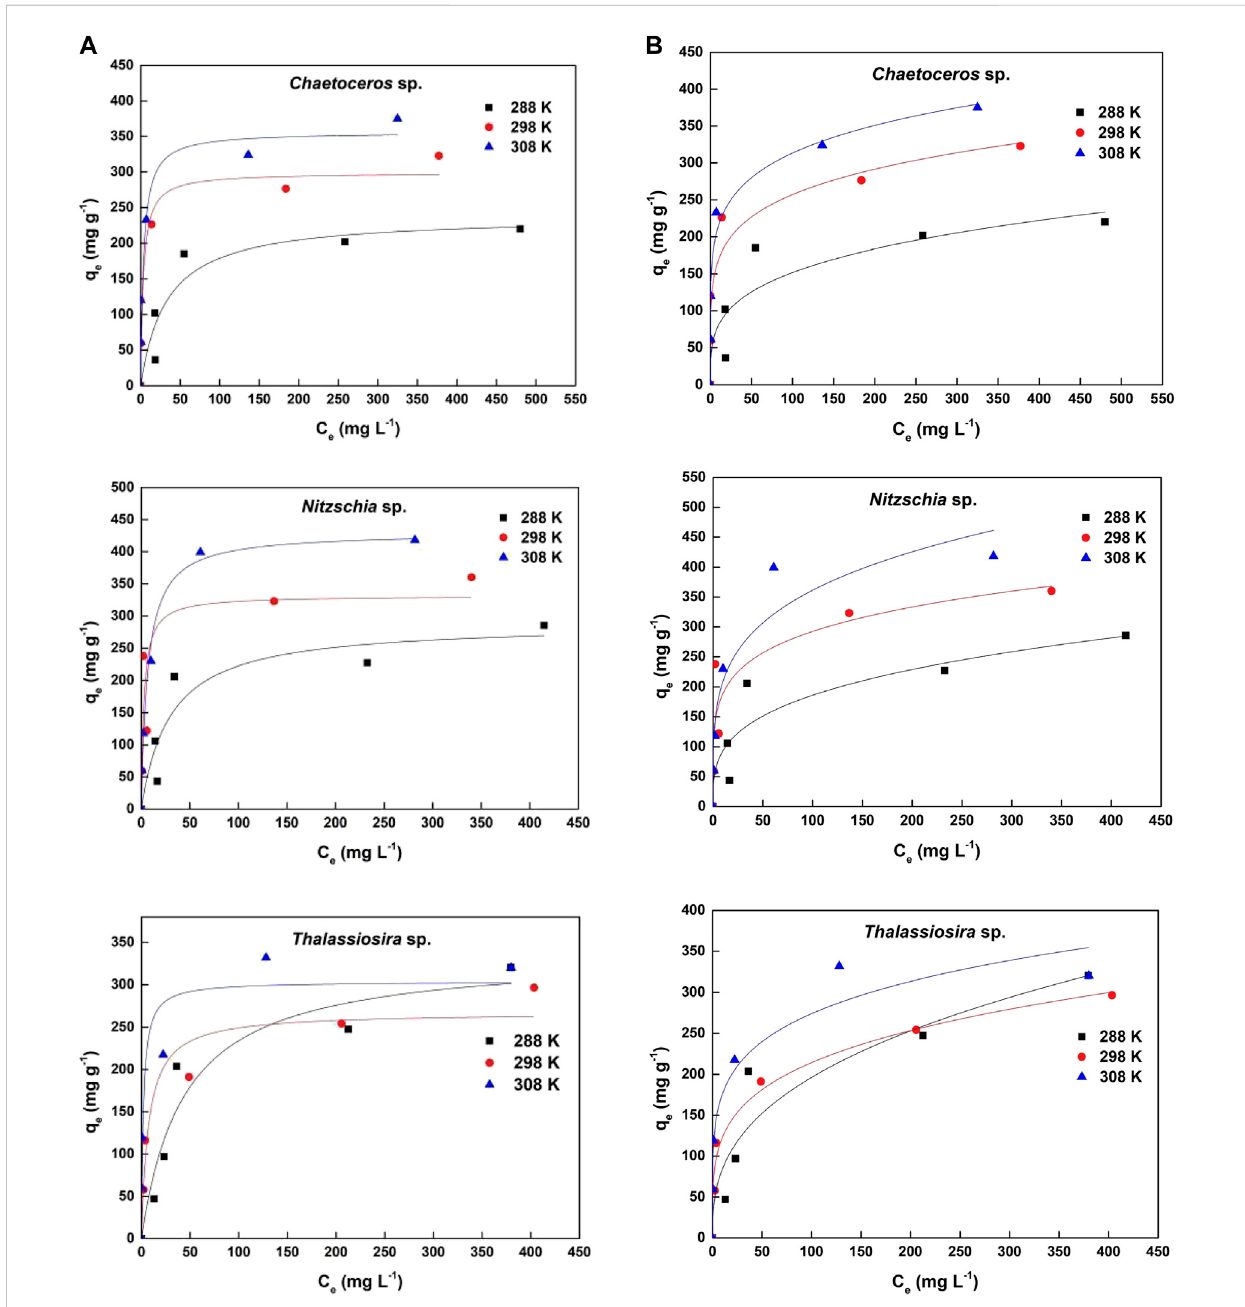
FIGURE 4 (A) Langmuir isotherm and (B) Freundlich isotherm non-linear fi ttings for Cd(II) adsorption by three kinds of non-living marine diatom